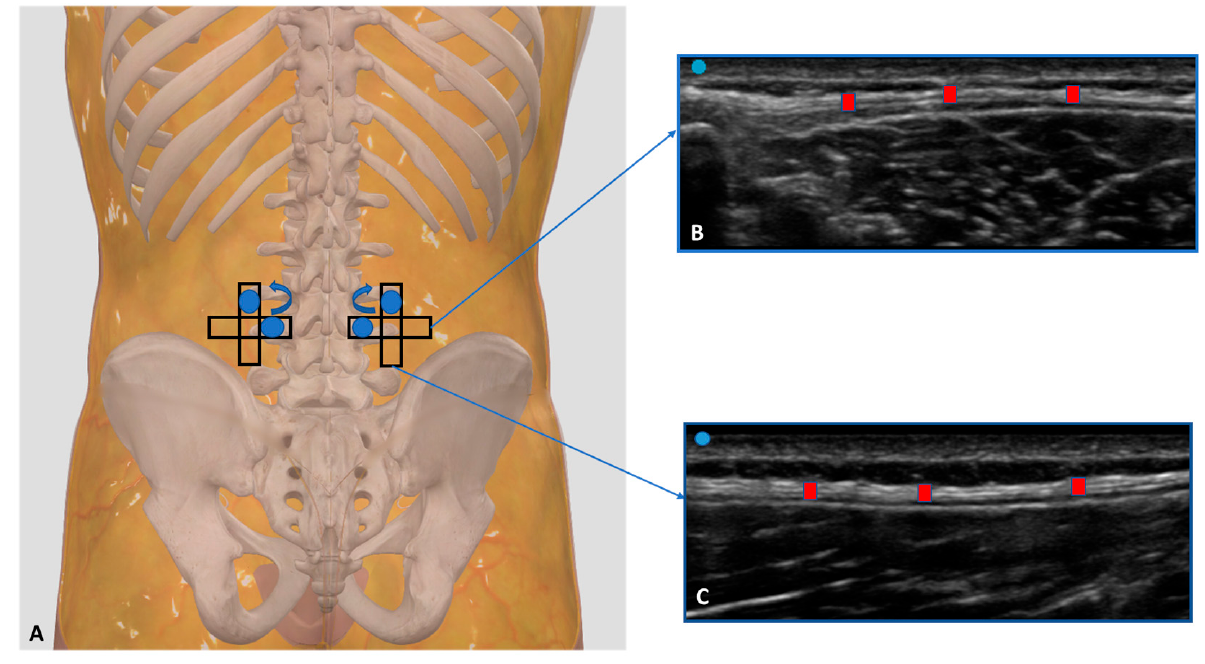
Figure 1. ( A ) Ultrasound measurements protocol of TLF thickness at the L3 level of the lumbar spine. Starting from the transversal axis to the long axis and rotating the probe 90° degree. Probe: black rectangle. ( B ) Transversal/short axis; ( C ) longitudinal/long axis. Red rectangle: TLF thickness.